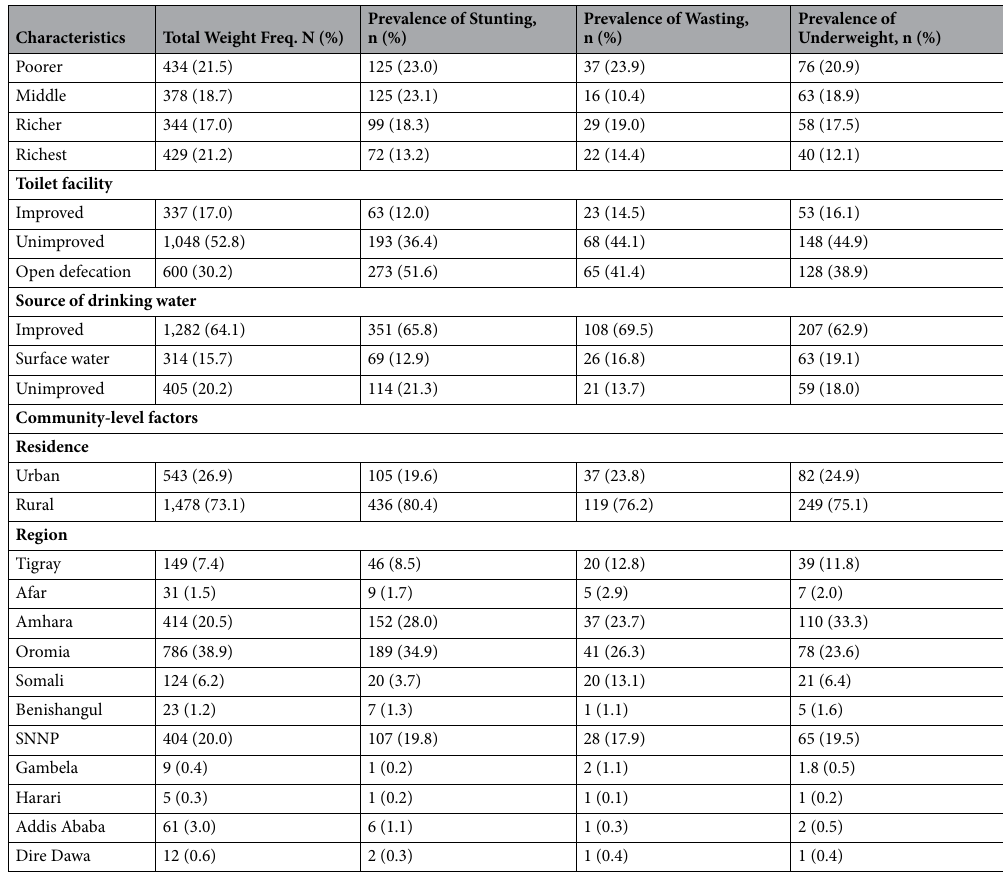
Table 1. Distribution of stunting, wasting, and underweight by categories of selected variables among children aged 0–23 months in Ethiopia, EMDHS 2019.